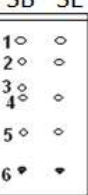
Fig. 7. Thin layer chromatography of the ethyl acetate fraction substances (SB) and (SE)